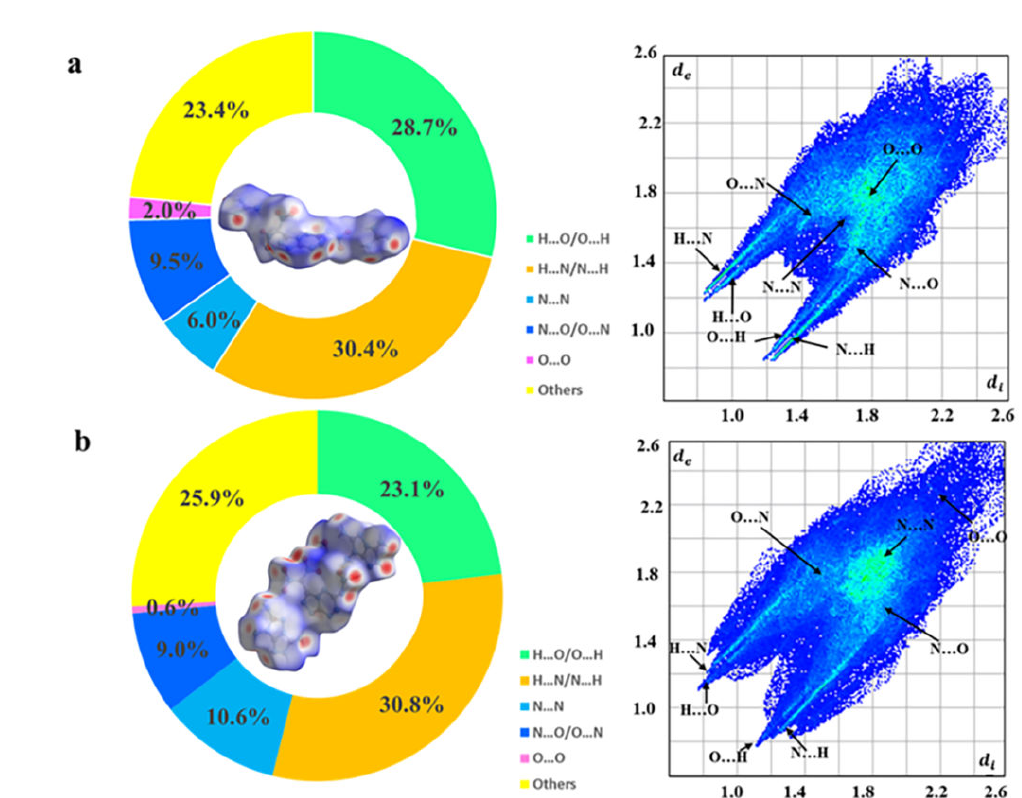
Figure 4. Hirshfeld surface analyses for 3 ( a ) and 4 ( b